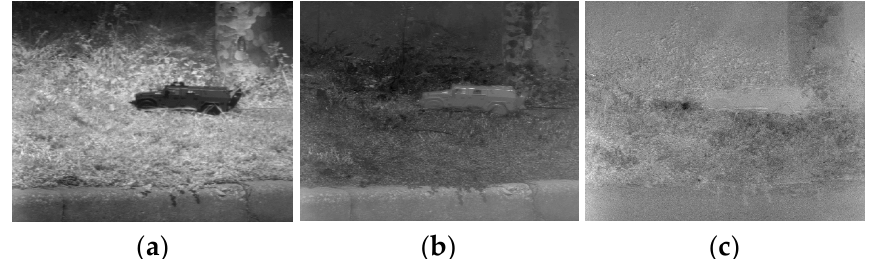
Figure 15. The first three principal component images after the PCA of the whole image in the second set of experiments. ( a ) The first principal component image, ( b ) The second principal component image, ( c ) The third principal component image.